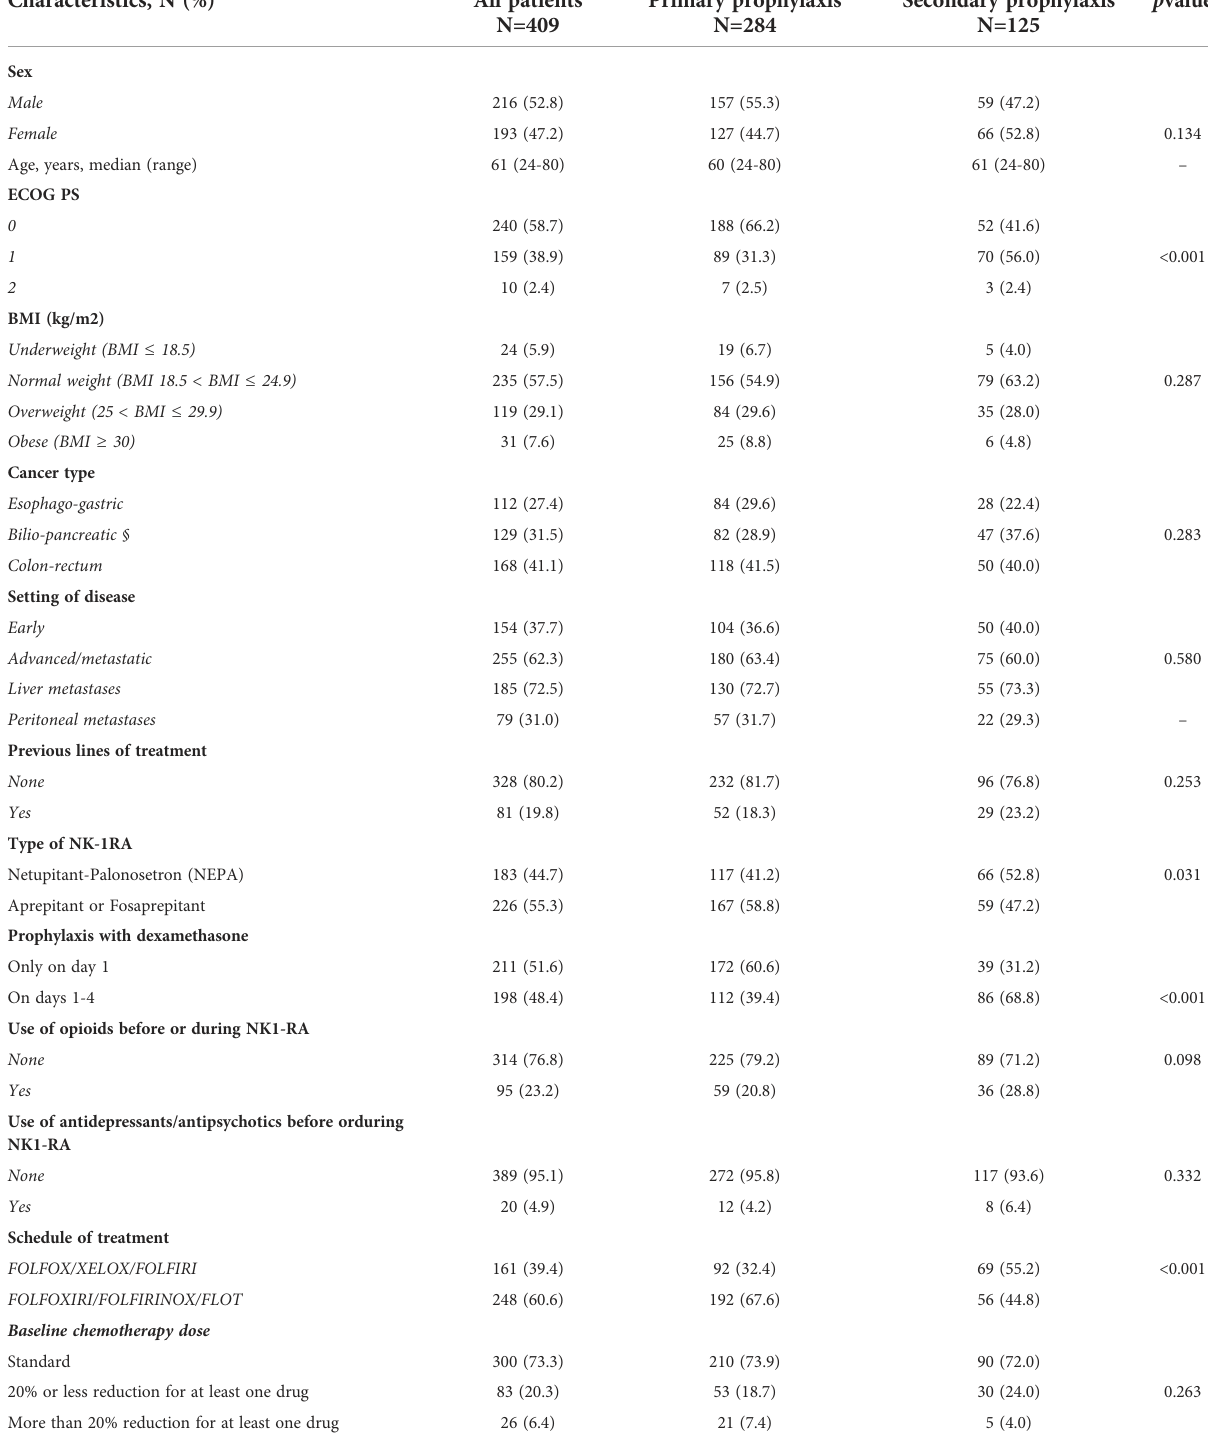
TABLE 1 Patients ’ characteristics in the overall population. Characteristics, N